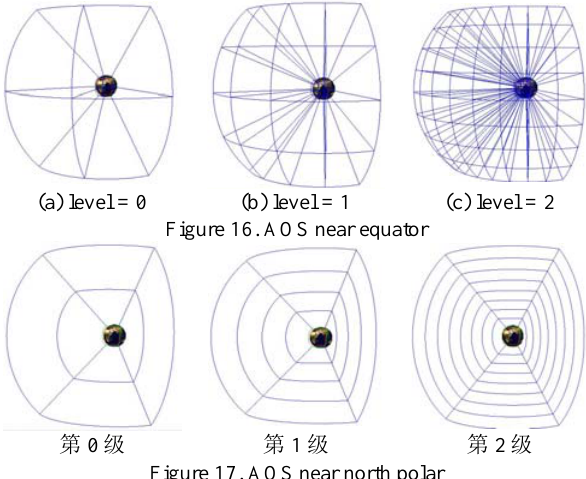
Figure 17. AOS near north polar